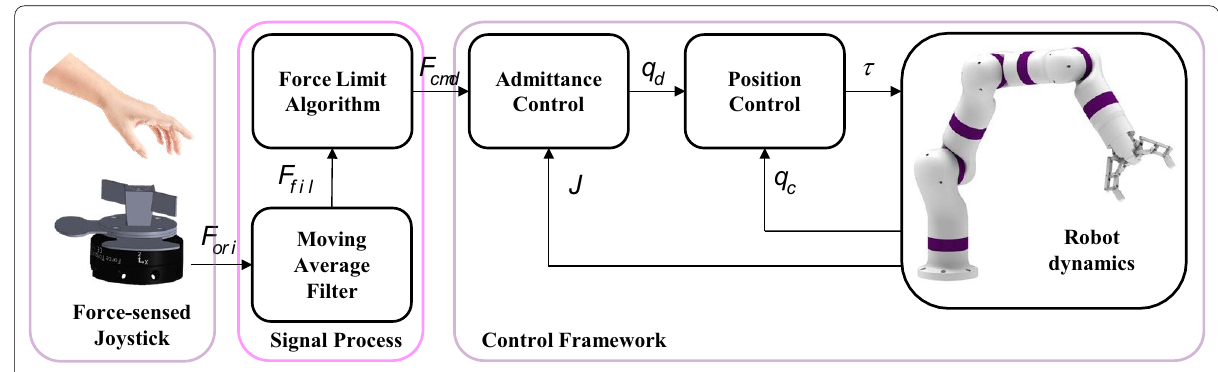
Figure 1 The system